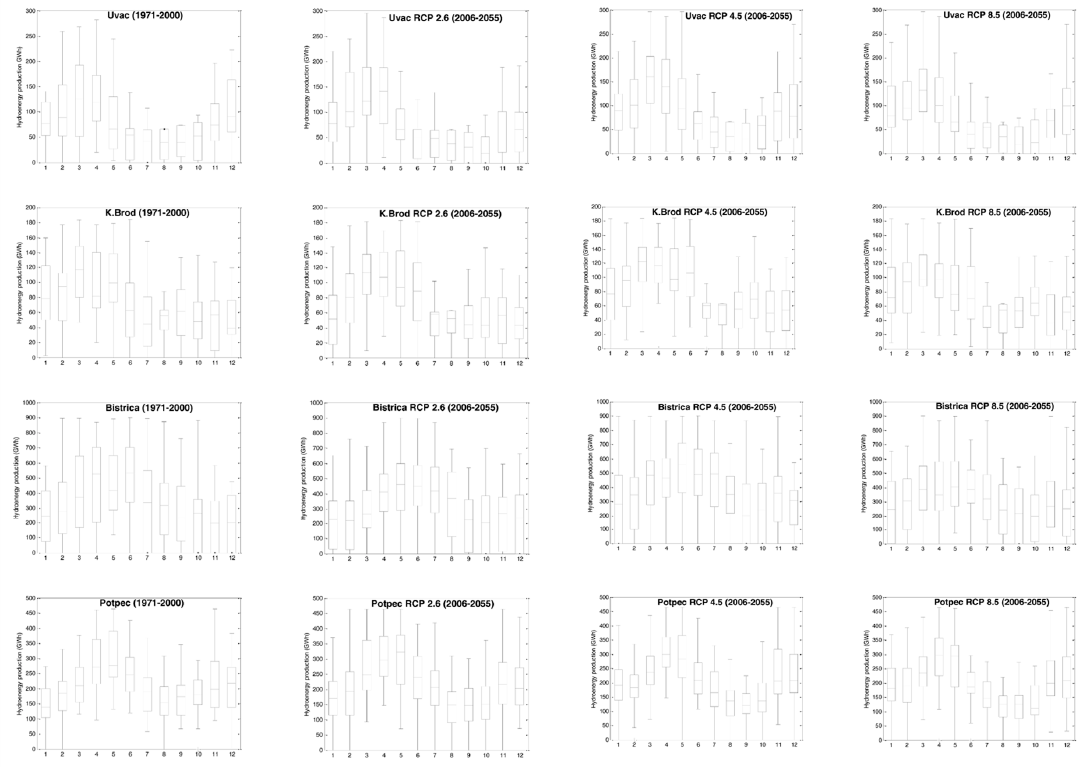
Figure 11. Box plots of the monthly hydropower generation of the Lim water system power plants (Uvac, Kokin Brod, Bistrica and Potpec).